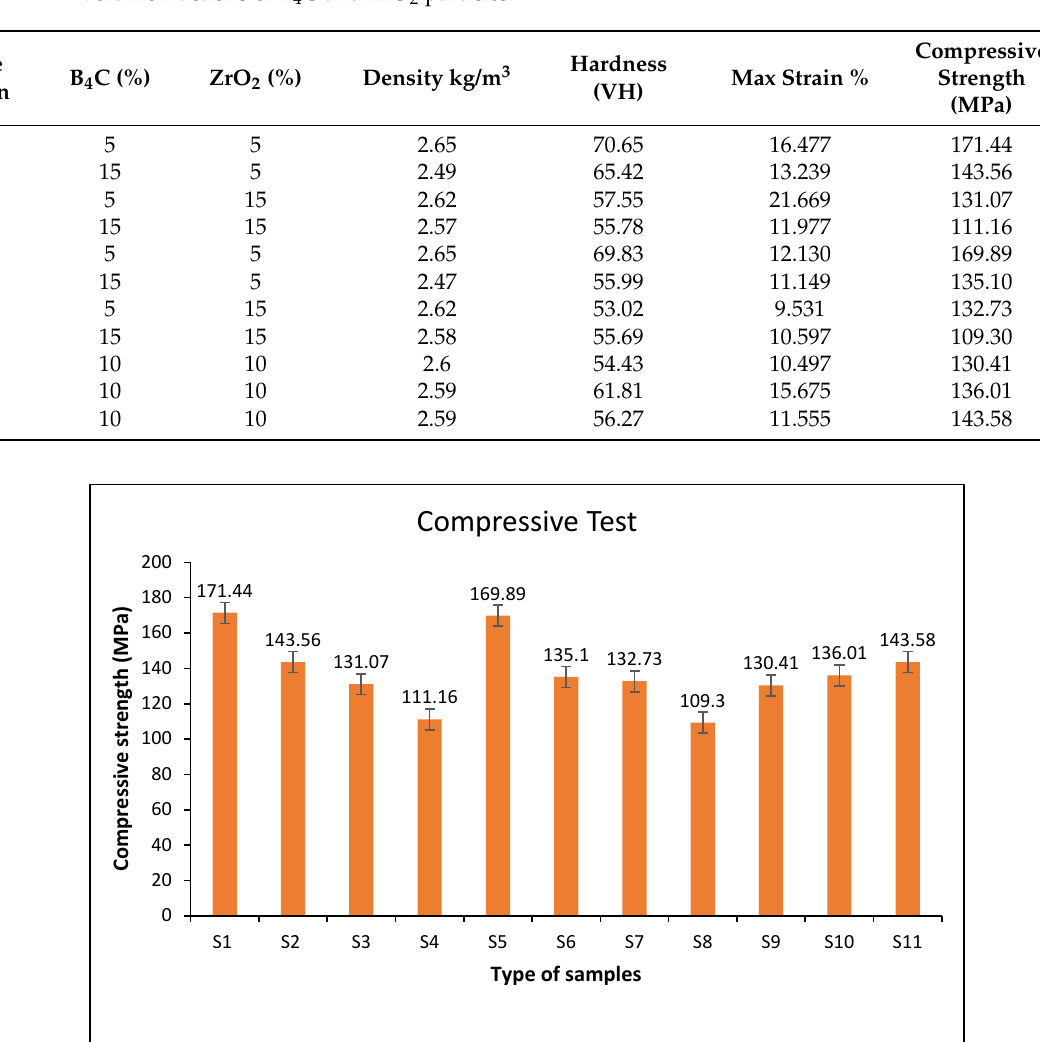
Table 5. Compressive strength, microhardness, and density of hybrid materials reinforced by different volume fractions of B 4 C and ZrO 2 particles.